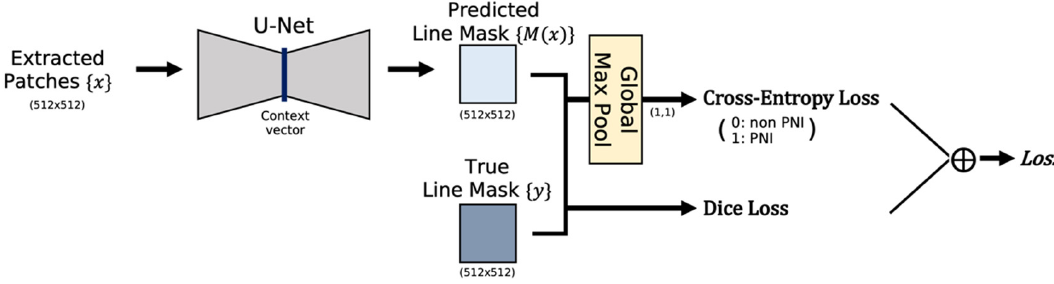
Figure 4. Main framework for PNI detection and segmentation with combined loss.